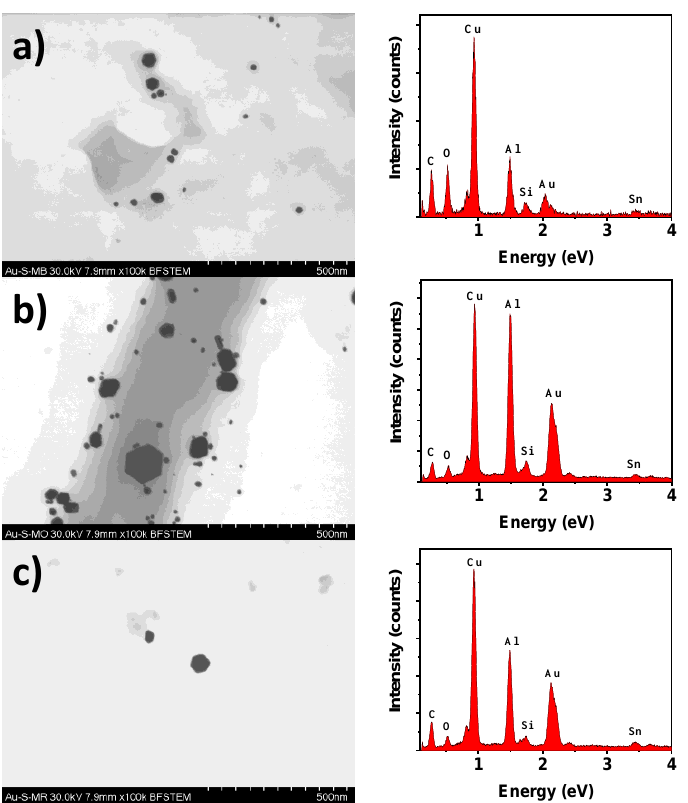
Figure 11. SEM and EDS analysis of the AuNPs after degradation of ( a ) methylene blue, ( b ) methyl orange, and ( c ) methyl red.